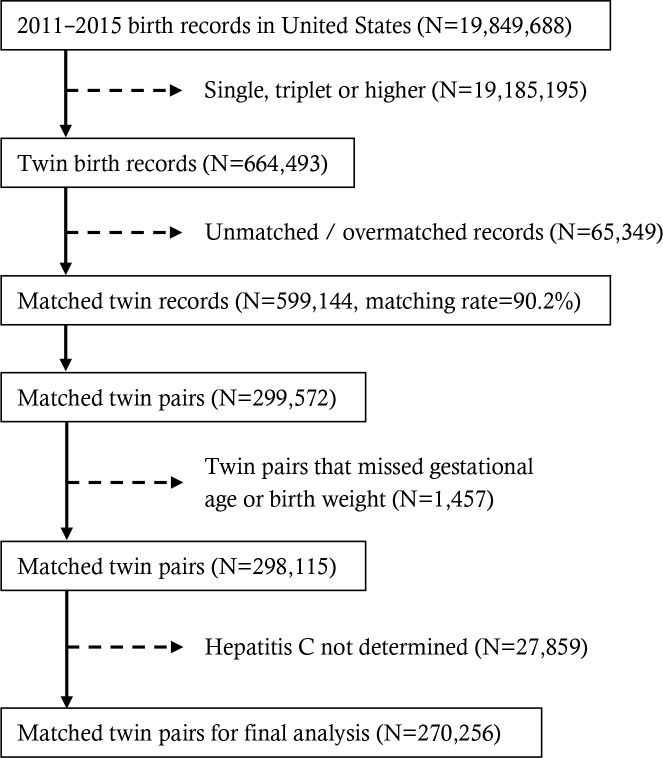
Flow chart of object selection.